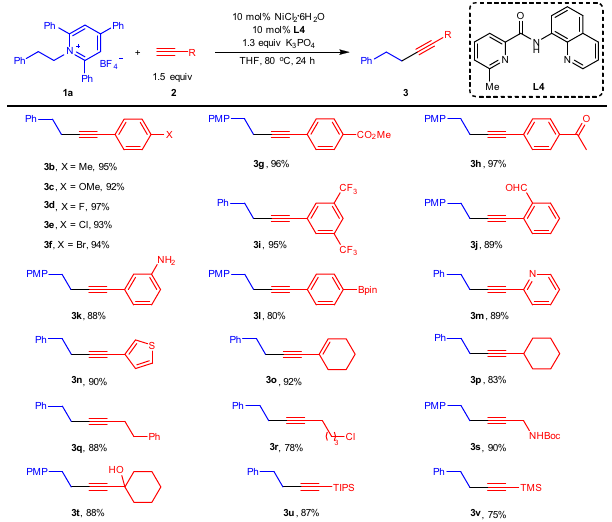
Fig. 2 Scope of terminal alkynes. Reaction conditions: 1a (0.3 mmol), 2 (0.45 mmol), NiCl 2 ·6H 2 O (10 mol%), L4 (10 mol%), K 3 PO 4 (1.3 equiv), THF (1.5 mL), 80 °C. Isolated yields. For 3g , 3h , 3j , 3k , 3l , 3s and 3t , reactions were conducted using p -methoxyphenethylpyridinium salt 1b instead of 1a . PMP p